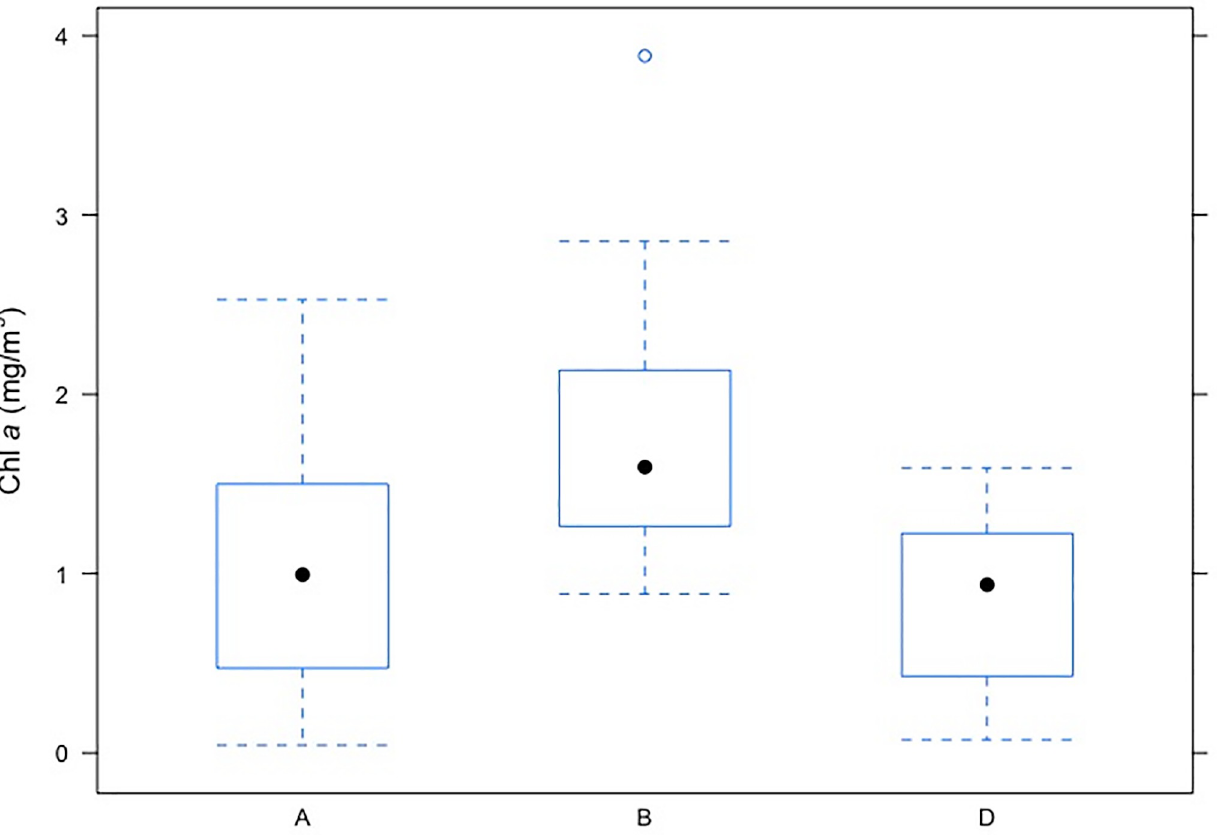
Fig 7. Box plot illustrating variation in phytoplankton biomass (Chl a ) at various interval of barge movement. X axis depicts instances of Chl a data collection along Bhagirathi Hooghly river stretch with respect to ‘barge movement’; A: 30 minutes after barge; B: 30 minutes before barge, D: During ‘barge movement’; Y axis denotes Chl a biomass (mg/m 3 ) at respective